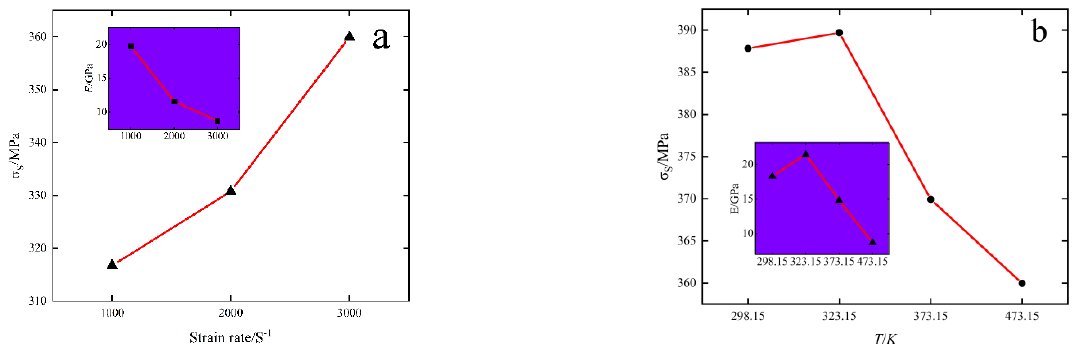
Figure 4. Changes in elastic modulus and yield strength under different conditions: ( a ) 473.15 K, ( b ) 3000 S − 1 .